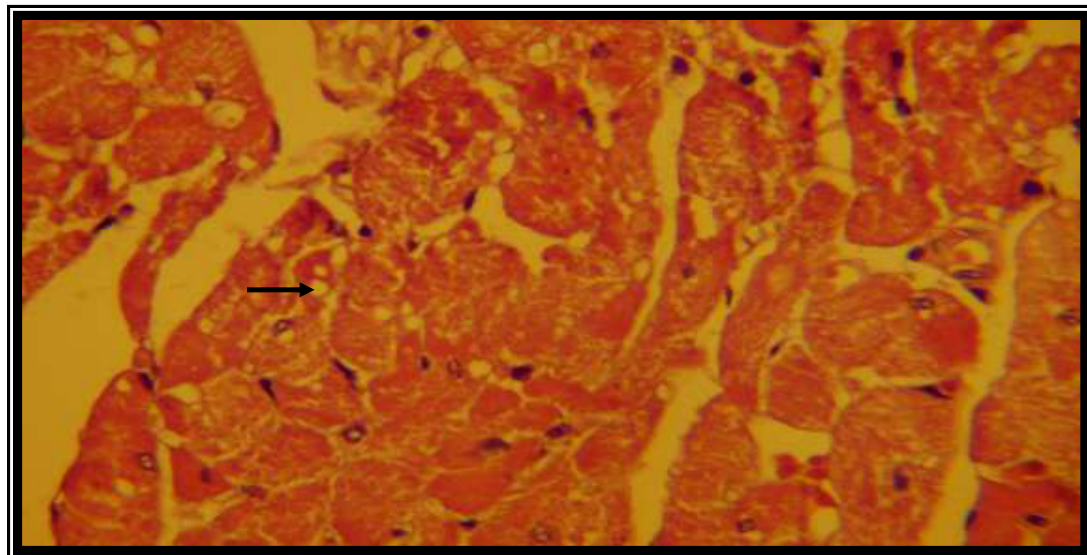
2000 Note: fatty change in muscles characterized by clear